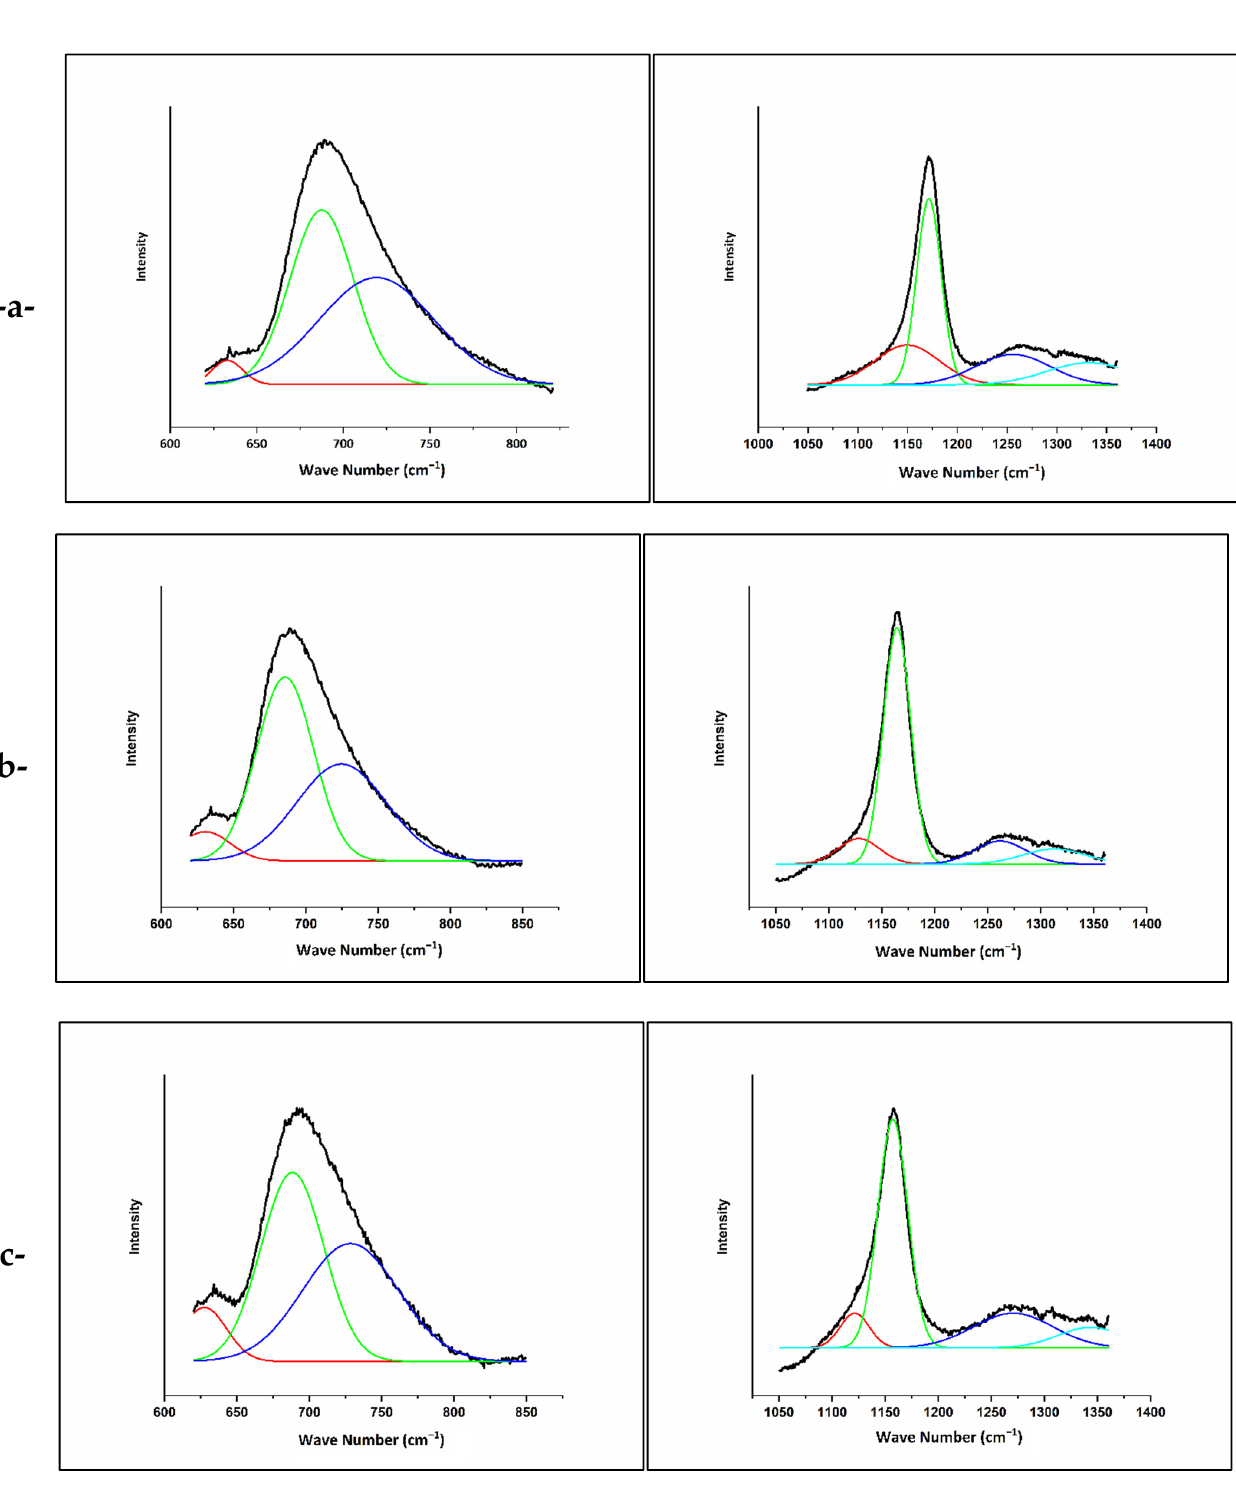
Figure 3. Raman spectra for concentrations of [K 2 O/(CaO+MgO)] ratio (%mol). VF1: 0.67 %mol, VF2: 1.33 %mol and VF3: 2 %mol.